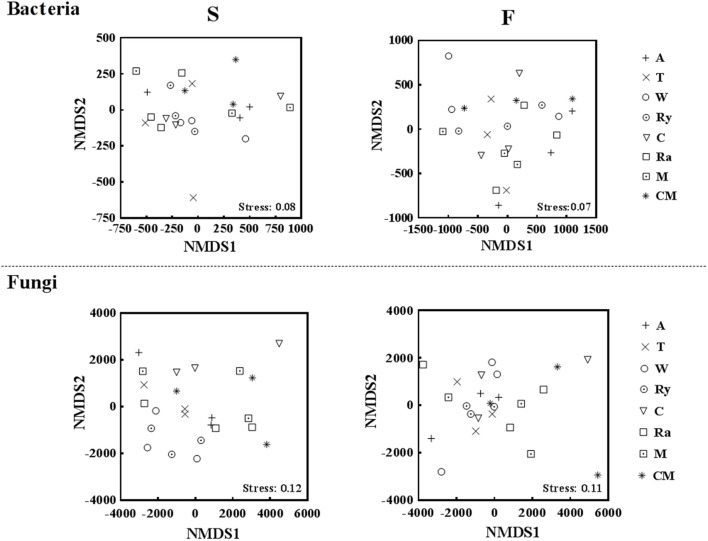
Nonmetric multidimensional scaling (NMDS) based on euclidean distance plot of all soil bacterial and fungal communities in the spring (S) and fall (F) cropping seasons.